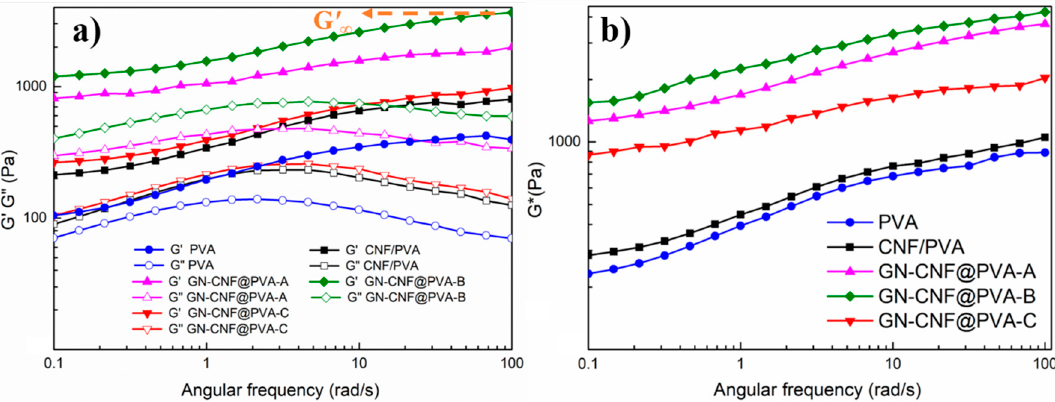
Figure 4. Rheological behavior of different gels under room temperature. ( a ) G ′ and G ″ versus ω ; ( b ) frequency dependence of G* versus ω . Table 2. Viscoelastic properties of hydrogels obtained from moduli plots.